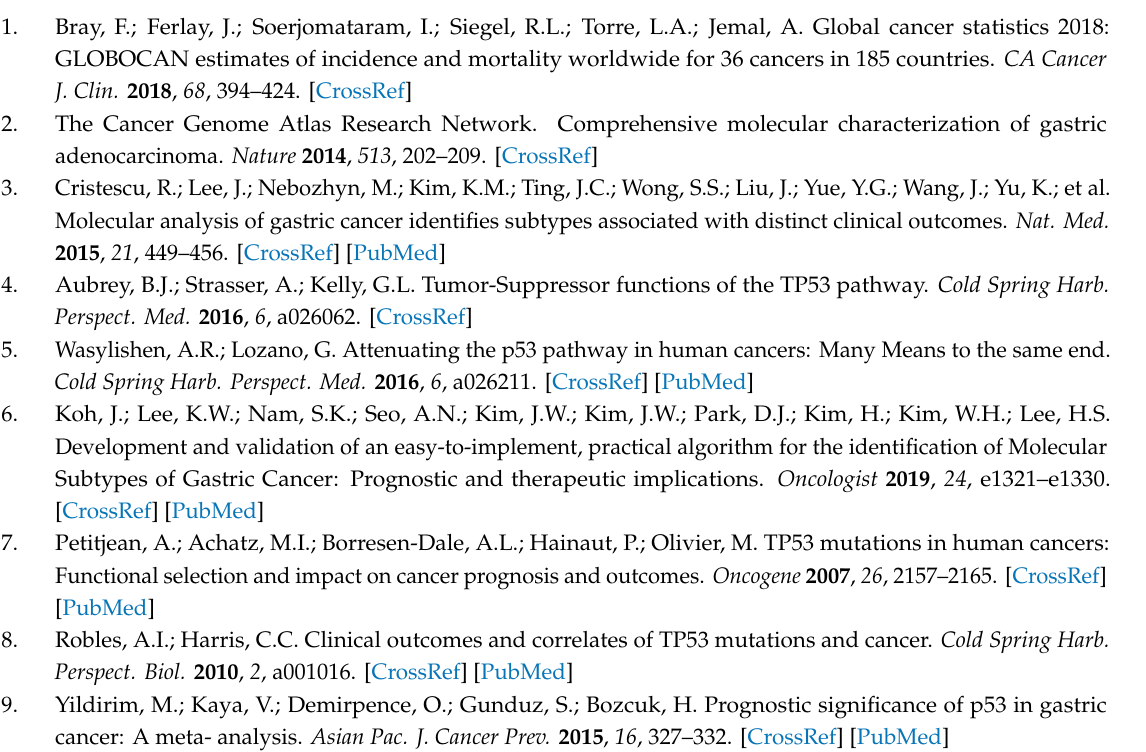
Table S1. Chemotherapy regimens of the preoperatively treated patients; Table S2. Comparison of Table S3. List of TP53 mutations identified by NGS in gastric carcinomas; Table S4. p53 expression of resection specimens and association with patient characteristics; Table S5. Multivariable analysis of survival including p53 expression and clinical factors in the resection specimens; Table S6. Survival data of the patient cohorts in association with the MSI status and the p53 expression; Figure S1. Examples of immunohistochemically p53 expression; Figure S2. p53 expression in the tumor biopsies before CTx and association with response and